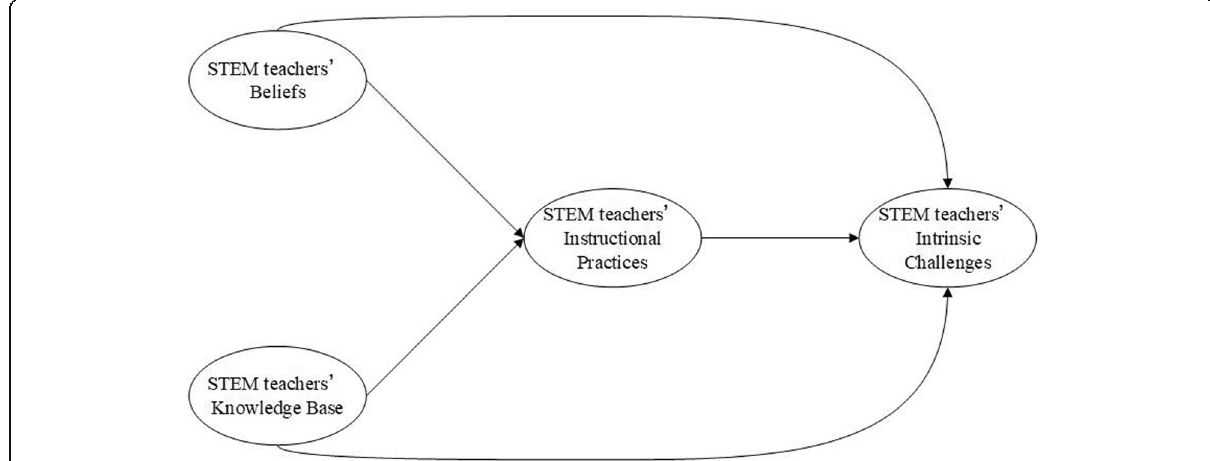
Fig. 1 Intrinsic challenges to STEM instructional practices perceived by teachers based on their beliefs and knowledge